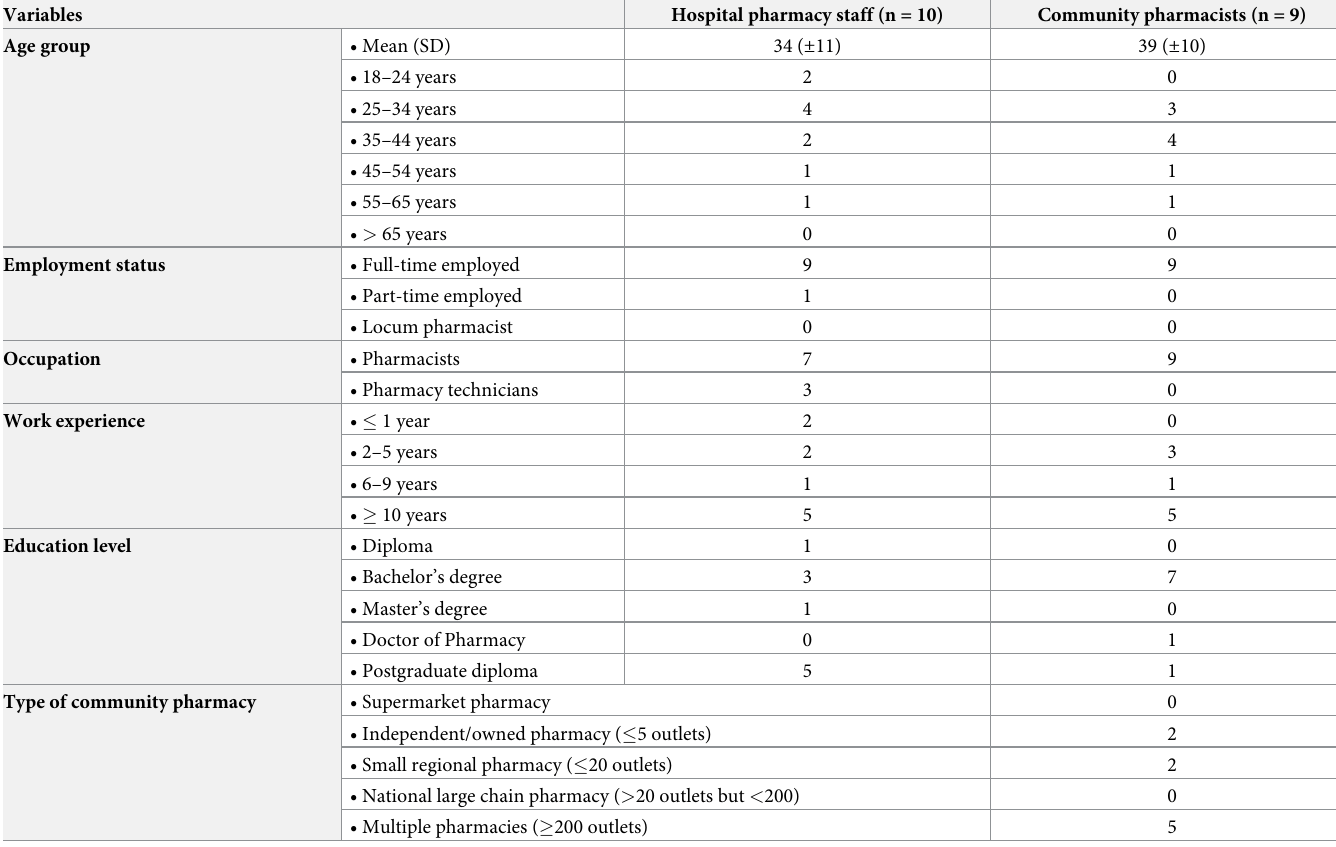
Table 2. HPS and CPs’ demographics.